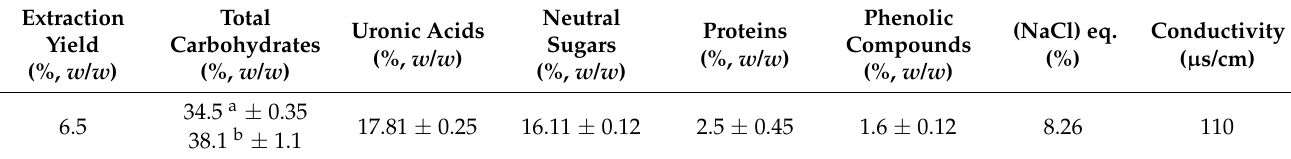
Table 1. Global composition of CFPS fraction extracted from Clematis flammula